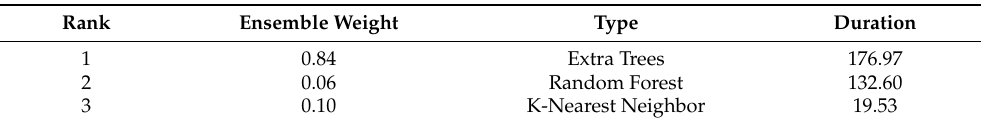
Table 3. The result of model selection performed by auto-sklearn when considering six outputs (Scenario 2).